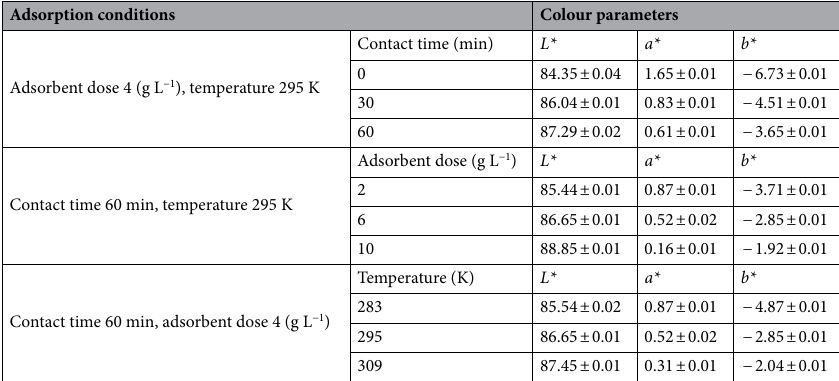
Table 4. Colour parameters at different adsorption conditions of the dye solution.